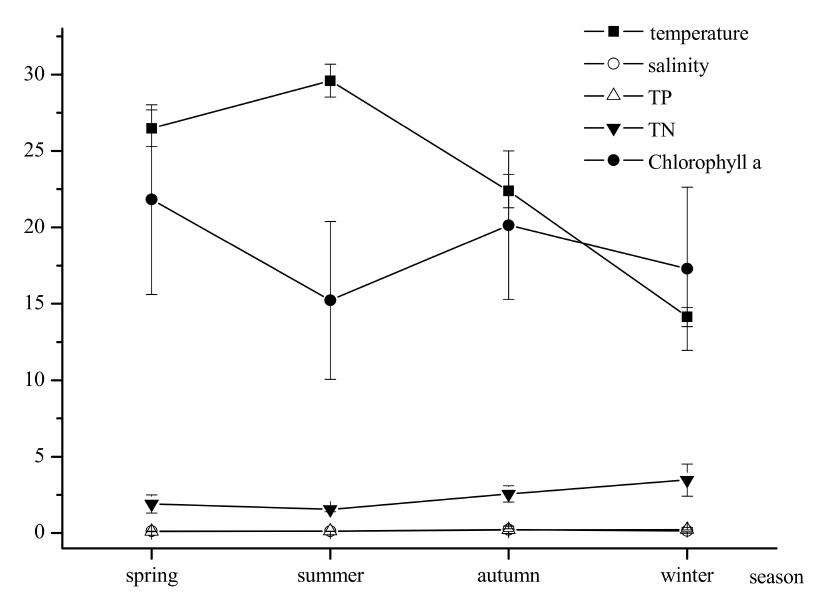
Figure 2. Seasonal variation of the main environmental factors in the Pearl River Delta. The units are: temperature, ◦ C; salinity, ‰; total phosphorus, mg/L; total nitrogen, mg/L; chlorophyll a content, µ